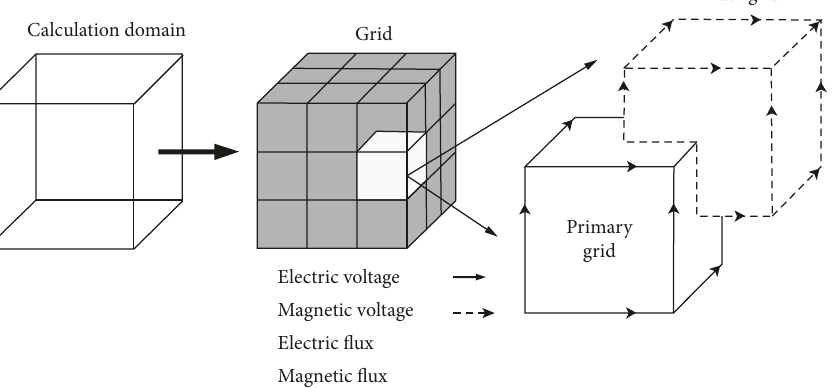
Figure 6: Discrete grid in FIT.